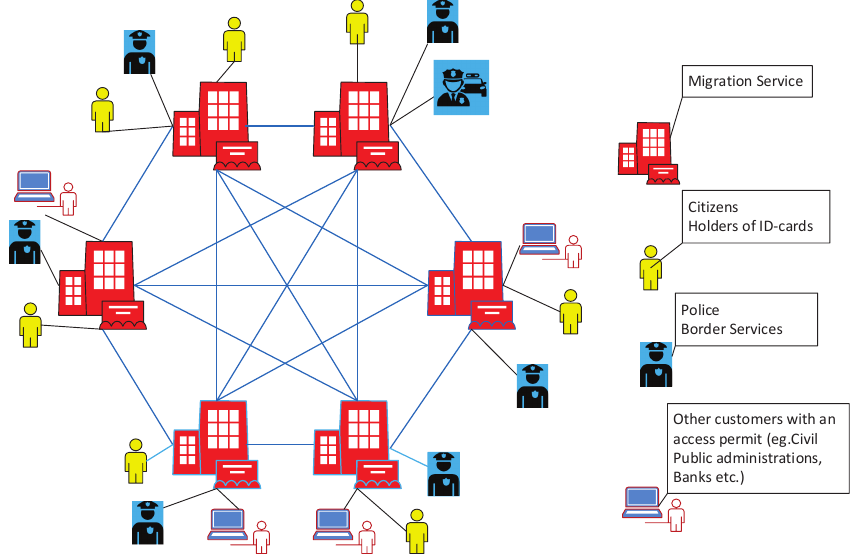
Figure 4. Overall structure of the network. The nodes are police, special services, migration department branches, and other state organizations that have access to personal data. The users of the information are police, migration officers, employees of special services, as well as third parties authorized by the state or holder of the information.